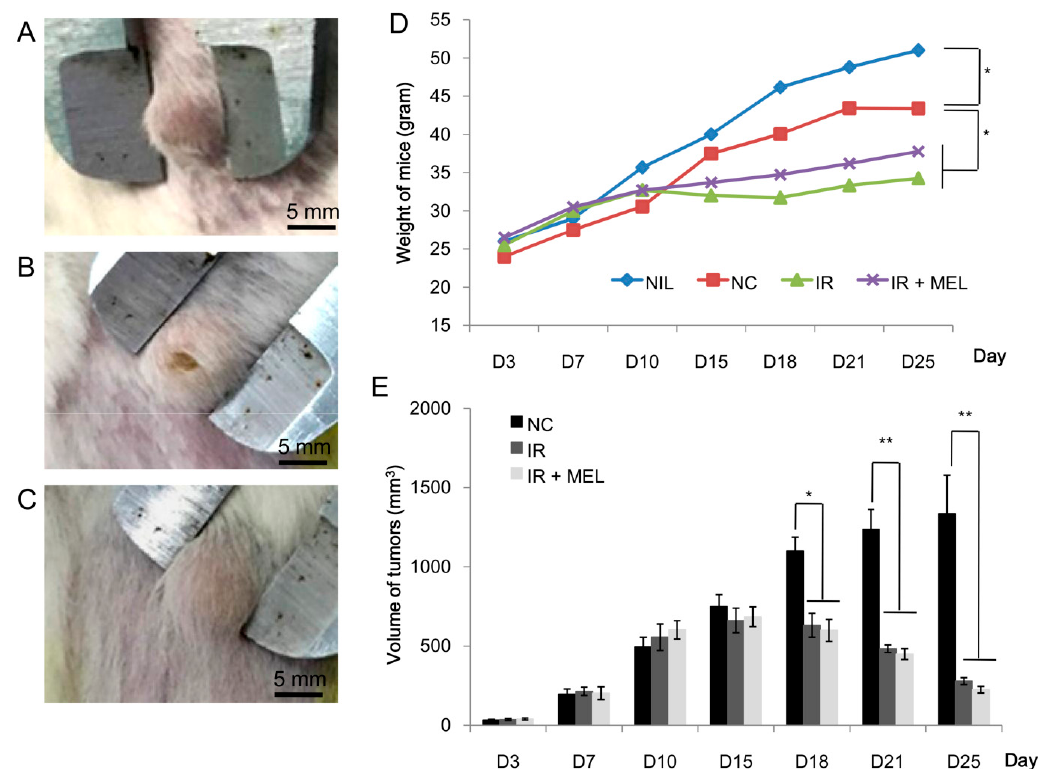
Figure 4. Tumor formation on the back of the NC control mouse ( A ), IR mouse ( B ) and IR + MEL mouse ( C ); weight of mice (g) over time ( D ); development of tumors on the backs of mice over time ( E ); NIL, mice with no induction of tumor or treatment; NC, mice receiving no treatment; IR, mice treated with a single dose of X-ray radiation; IR + MEL, mice treated with 40 mg / kg nanomelanin once before X-ray radiation and again 2 days post-radiation. *, **: Significant differences with P < 0.05 and P < 0.01, respectively.